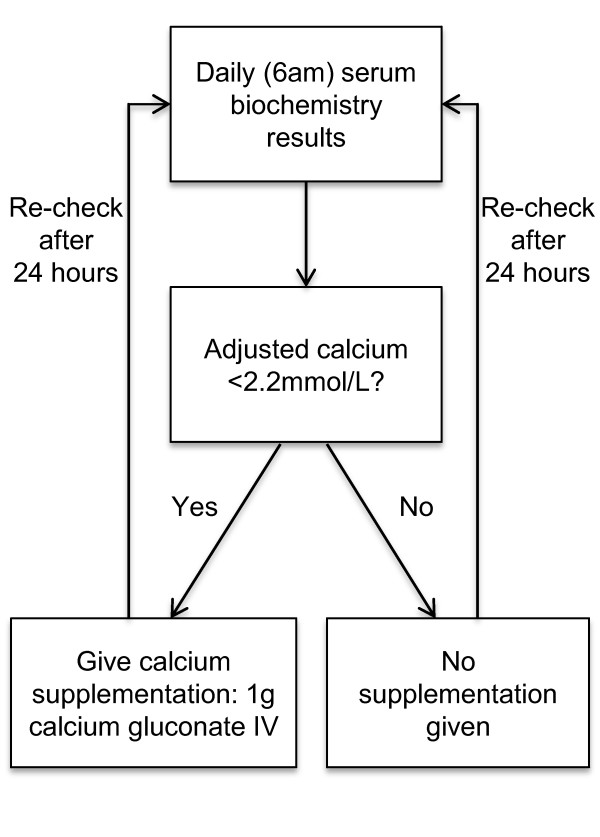
Flow chart outlining calcium supplementation protocol followed on units in which the study was carried out.